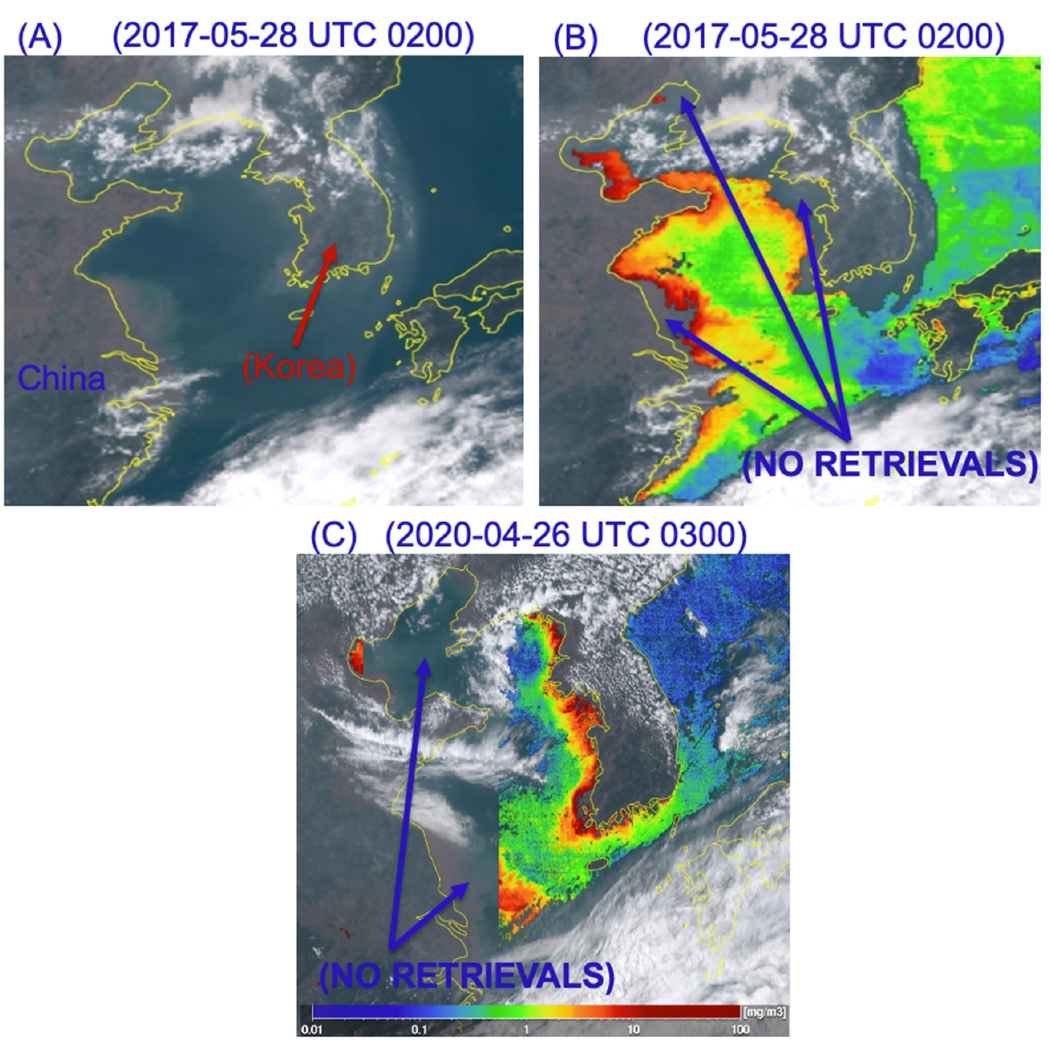
Figure 2. ( A ): A true color RGB image acquired with the Japanese Advanced Himawari Imagers (AHI) instrument over part of Japan, Korean Peninsula, and eastern part of China at UTC 0200 on May 28, 2017; ( B ): Similar to ( A ) but with a false chlorophyll concentration image overlaid; and ( C ): Another case of an AHI false color chlorophyll concentration image overlaid on an RGB image that was acquired on April 26, 2020 at UTC 0300.